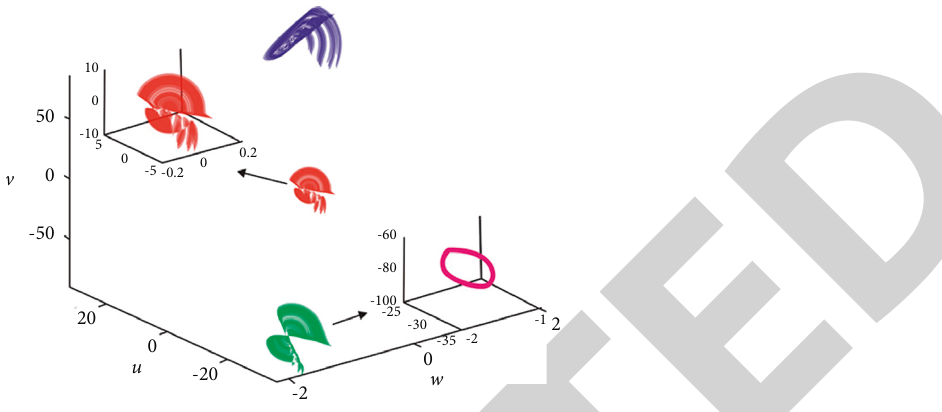
Figure 9: Phase diagram of the system changing with the initial value y